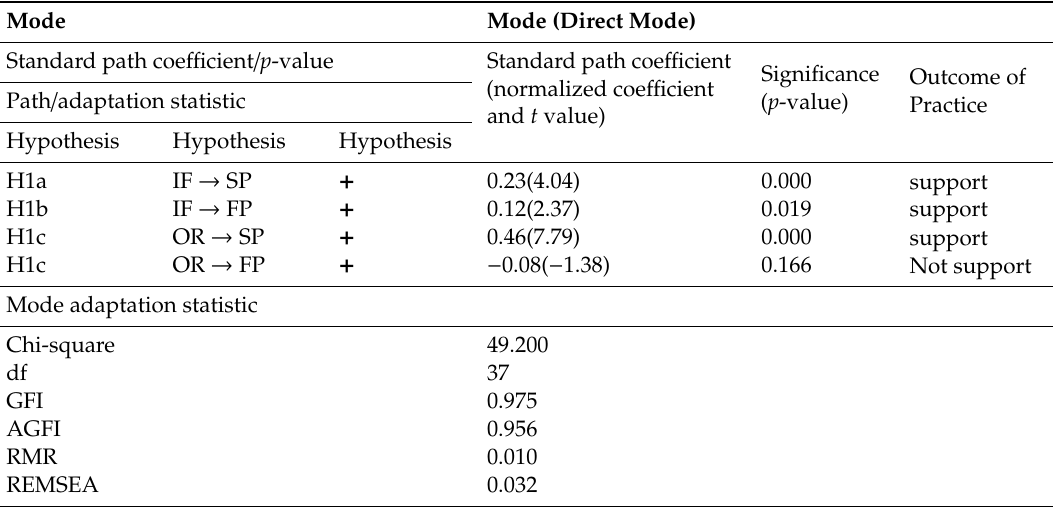
Table 1. Direct e ff ect analysis